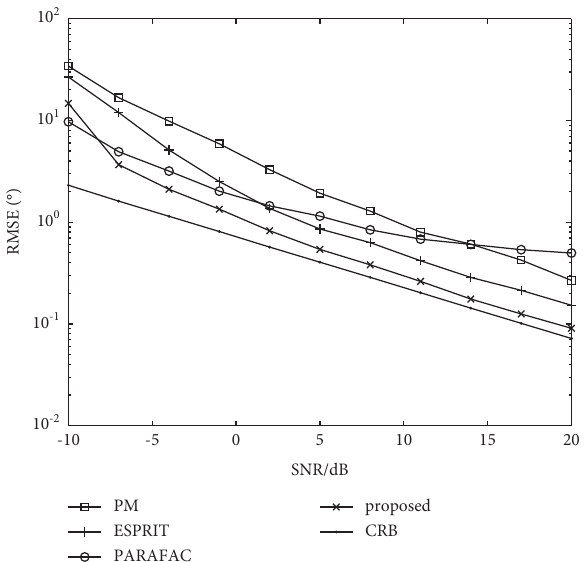
Figure 7: c estimation of different algorithms versus